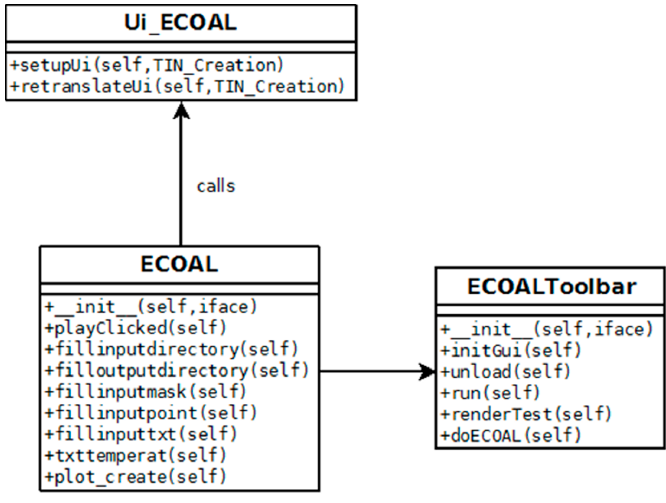
Figure 7. GIS-ECOAL application class diagram.